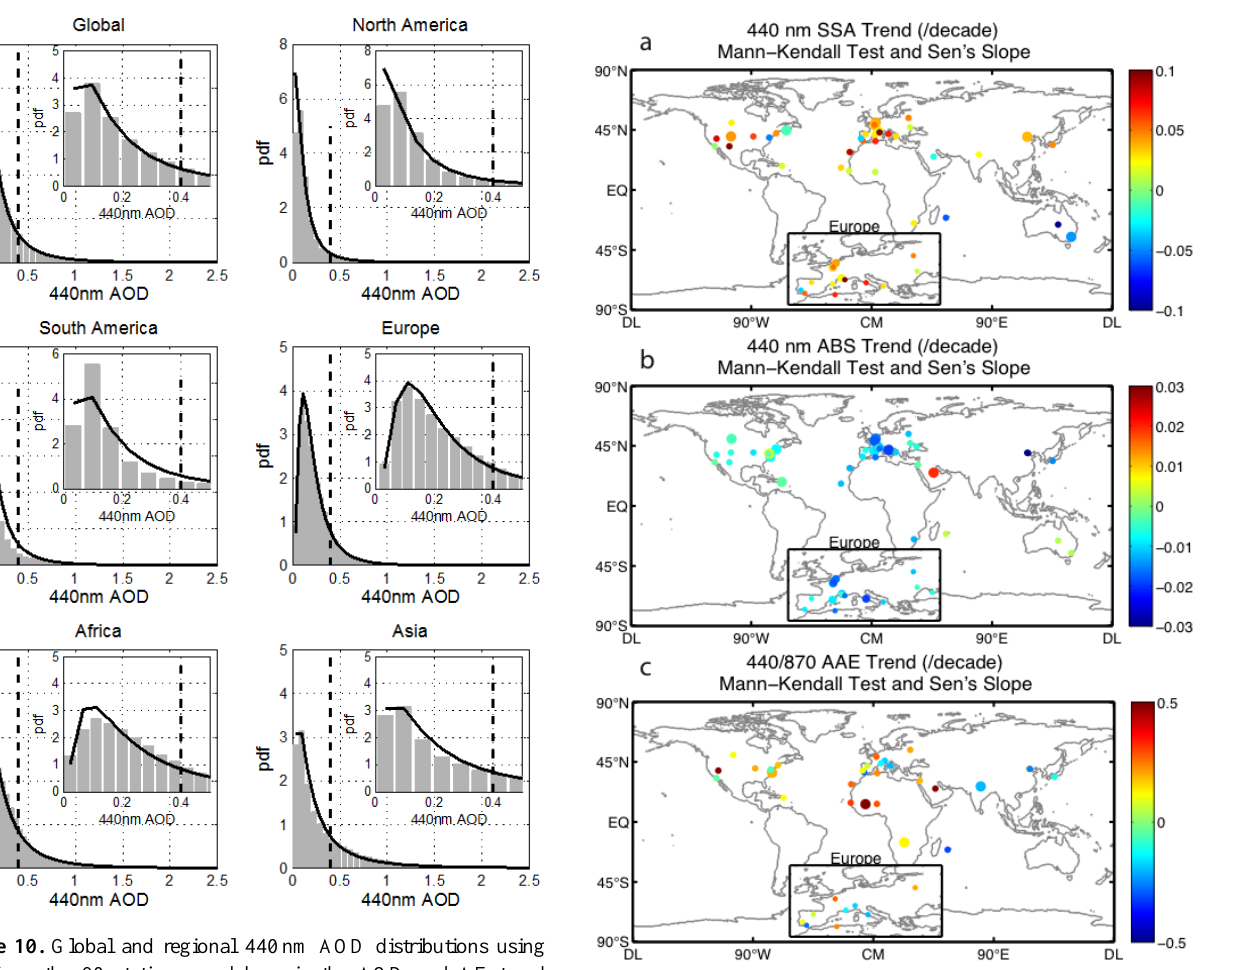
Figure 11. Global SSA (a) , ABS (b) and AAE (c) trends using level 1.5 data. Only statistically significant ( > 90%) trends are shown. The smaller dots indicate trends at 90% significance, while larger dots indicate trends at 95% significance. The magnitude of the trend (decade − 1 ) is indicated by the color of the dots, following the color scale on the